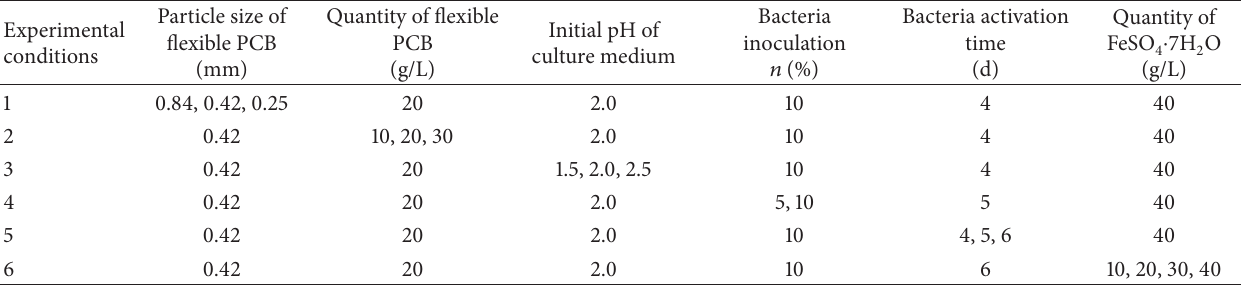
Table 4: Conditions of the experiment.